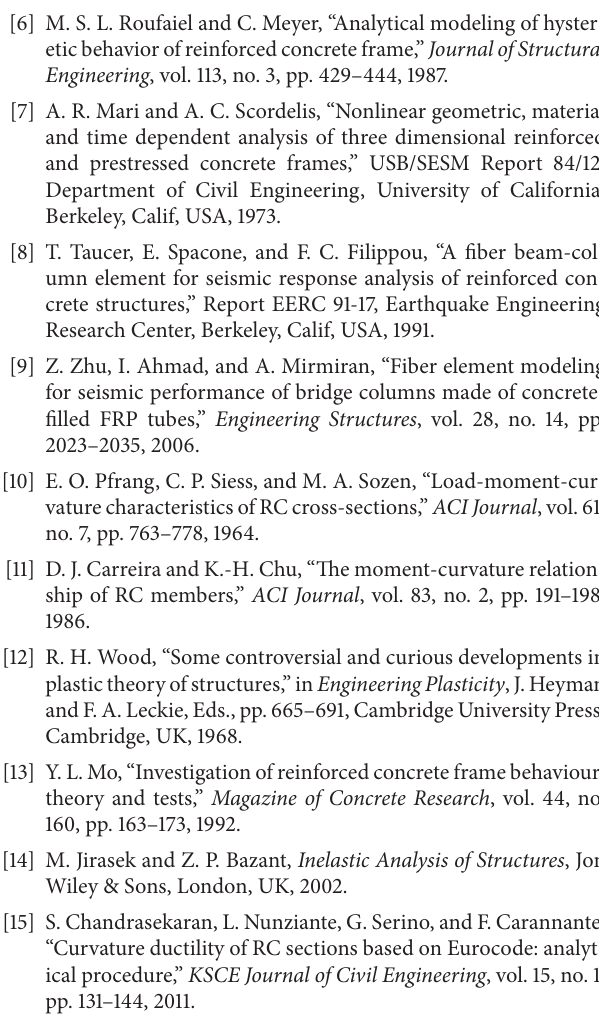
the assigned values of curvature and compression level is required, but each iteration step implies the simple use of the same equilibrium equation for an updated value of the nor- malized neutral axis